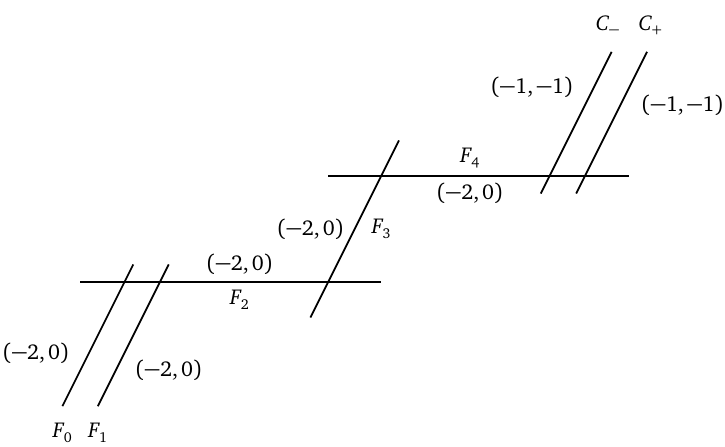
Figure 9: Codimension 2 fiber projecting to the intersection of and I ∗